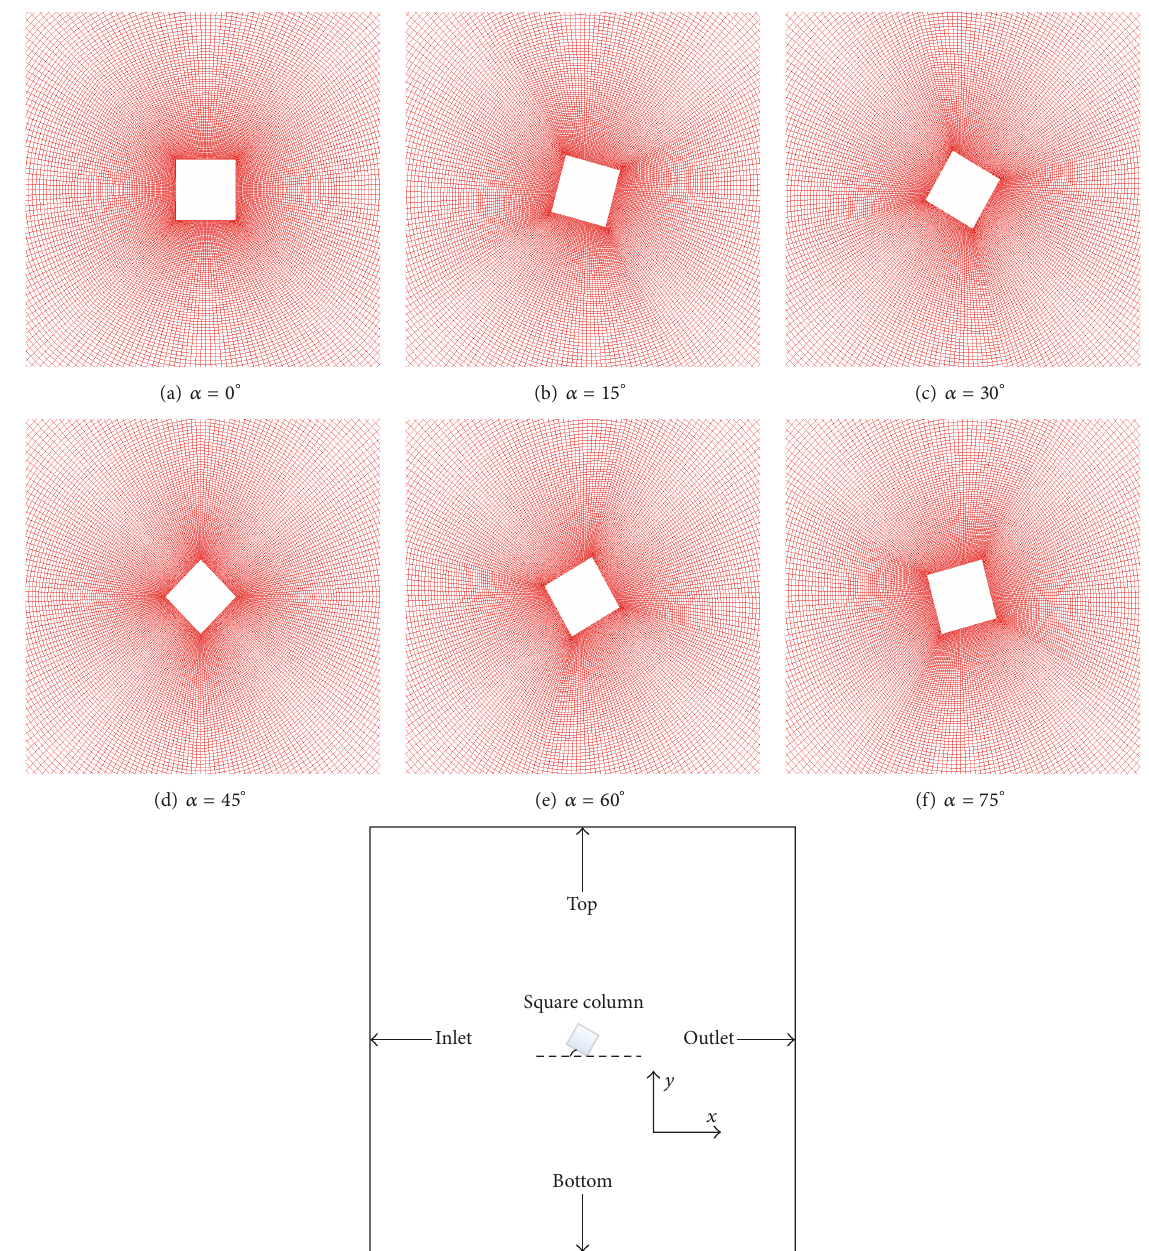
Figure 2: Computational grid and boundary